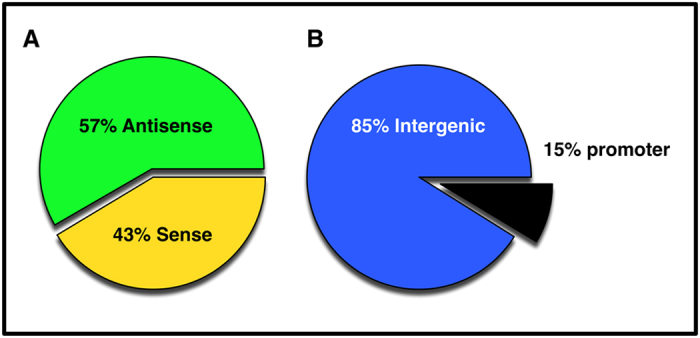
Global classification of lncRNAs.(A) Characteristics of genomic regions differentially expressed during ISAV infection. Unknown genomic regions without any overlapping annotated gene were classified in sense and antisense lncRNAs. (B) Short reads were assigned to one of three nonoverlapping categories. The promoter, intronic, and intergenic categories were defined by the genomic coordinates for known immune related genes and include only reads that map to unique genomic locations.